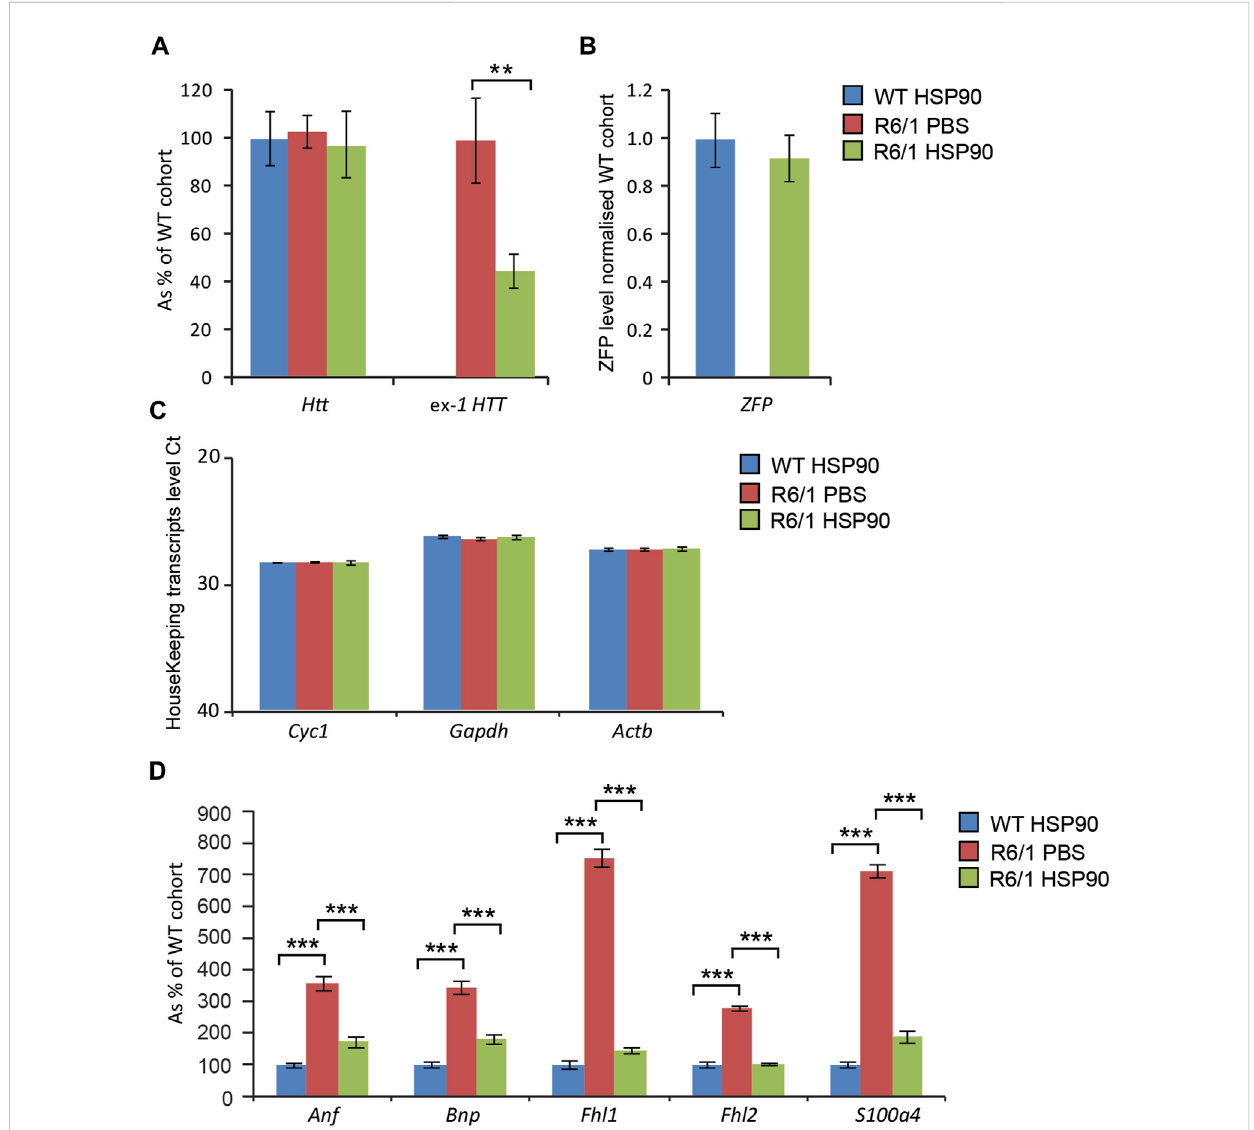
FIGURE 6 EffectsofintrajugularveininjectionofAAVexpressingmZF-KRABunderHSP90promoterintheHDheart.Transcriptlevelsofwildtype Htt remained unchangedwhilemutantexon-1 Htt transcriptlevels weresigni fi cantlyreducedwithzinc fi ngerintheheartsofR6/1mice,incomparisontoR6/1injected with PBS or wild-type mice injected with mZF-KRAB only (A) . There was an apparent expression of the zinc fi nger mZF-KRAB transcript in the hearts of both WT and R6/1 mice at 6 weeks post single injection (B) . All transcript levels were normalized to three housekeeping genes (C) : Raw crossing threshold (Ct) data for a panel of housekeeping genes are presented for the following gene transcripts: Cyc1 (Cytochrome c-1, 66445), Atcb (Actin, beta, cytoplasmic, 11461), Gapdh (Glyceraldehydes-3-phosphate dehydrogenase, 14433) (D) . A number of biomarkers of the HD pathology in the heart have been signi fi cantly reversed: Anf (atrial natriuretic factor), Bnp (brain natriuretic protein), members of the four-and-a-half LIM family Fhl1 and